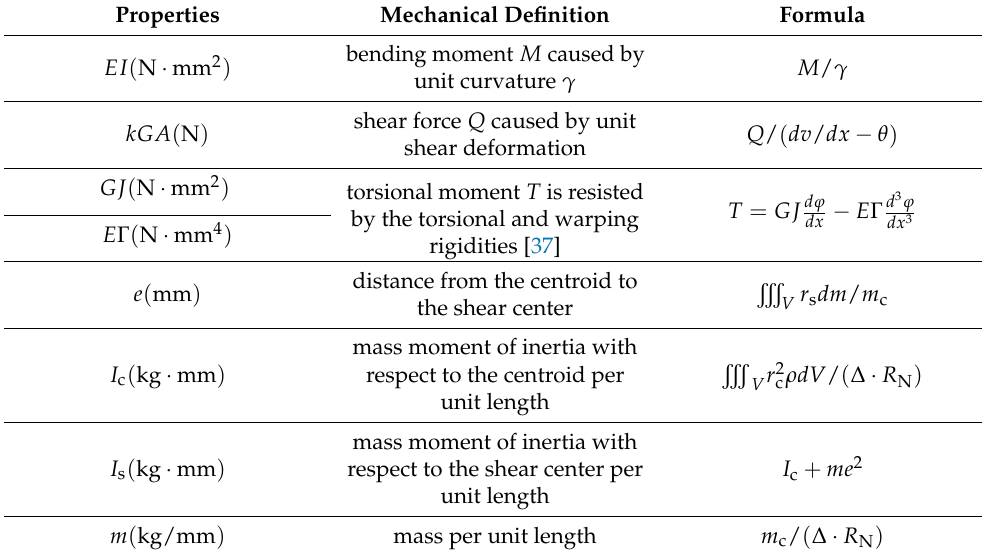
Table 2. Properties of the FT and FTCT